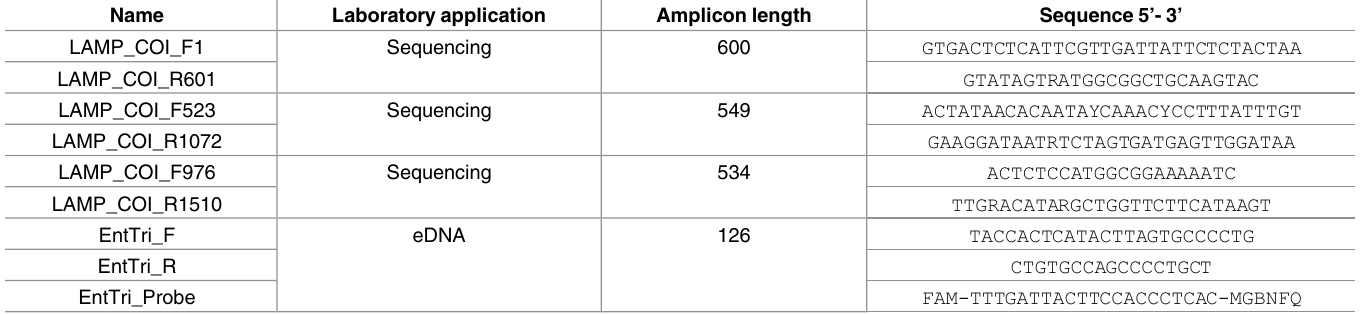
Table 1. Primer sequences for amplification and sequencing of the COI region of the Pacific lamprey mitochondrial genome; and sequences for components of the eDNA